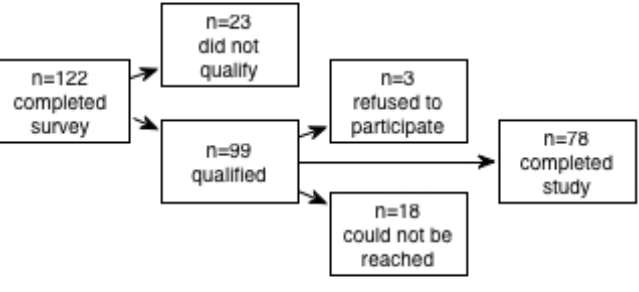
Figure 1. A breakdown of the number of individuals who completed the screening survey, qualified as eligible, agreed to participate, and completed the